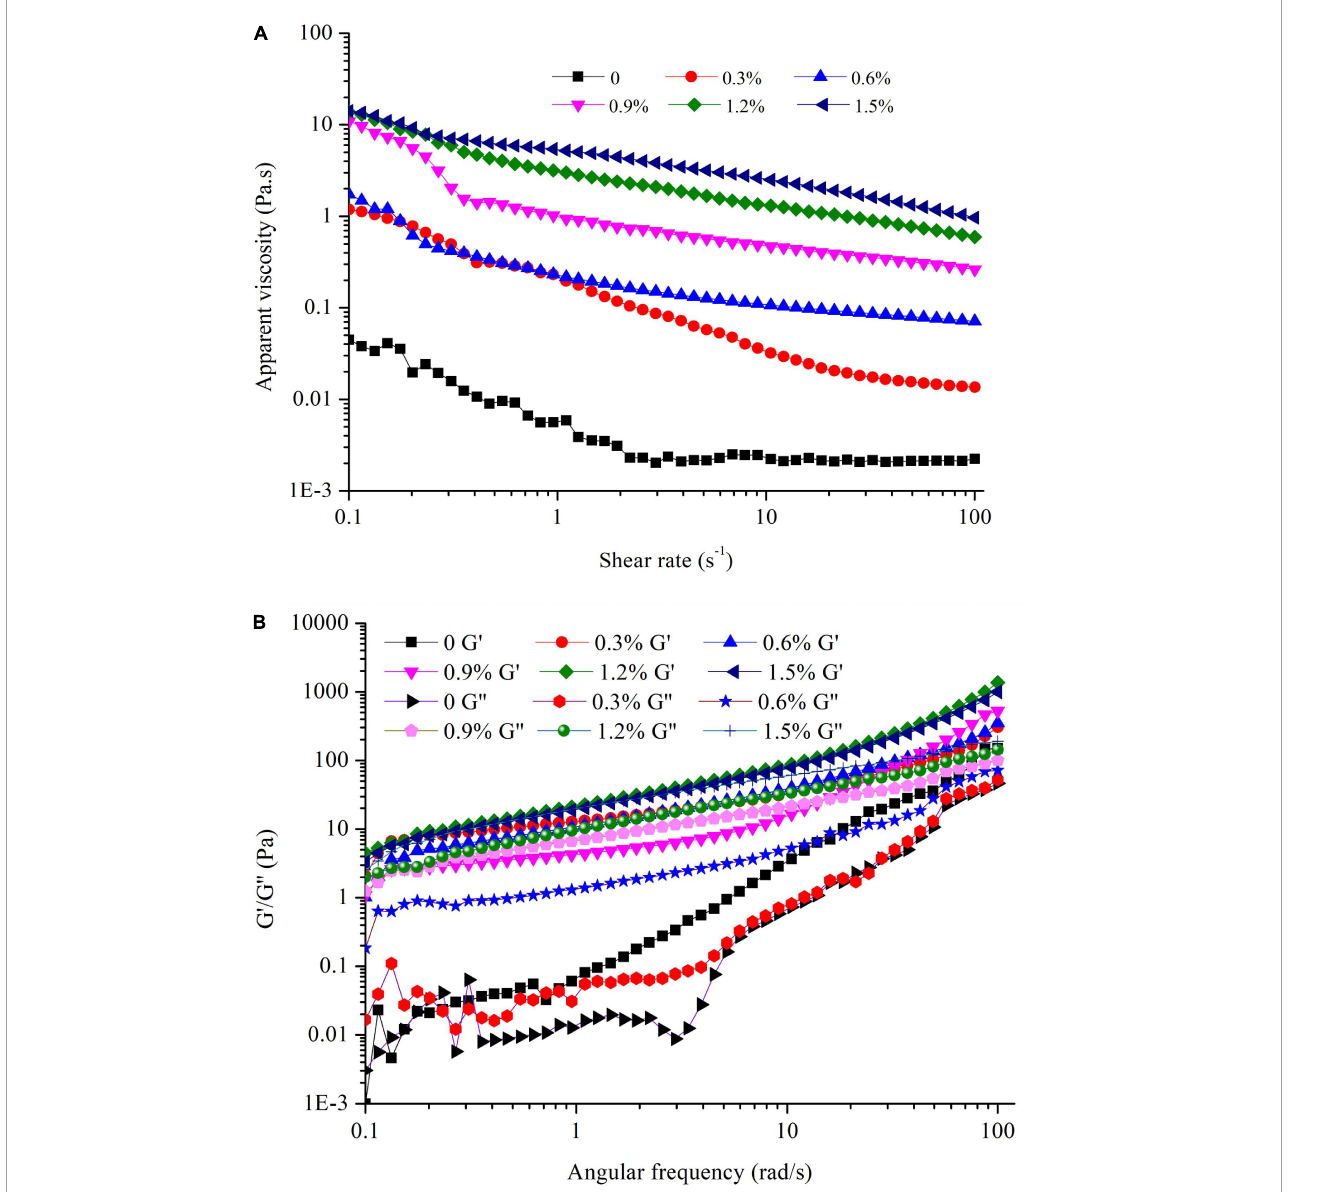
FIGURE6 The apparent viscosity (A) , G (cid:48) and G (cid:48)(cid:48) values (B) of the emulsions with different concentrations of compound